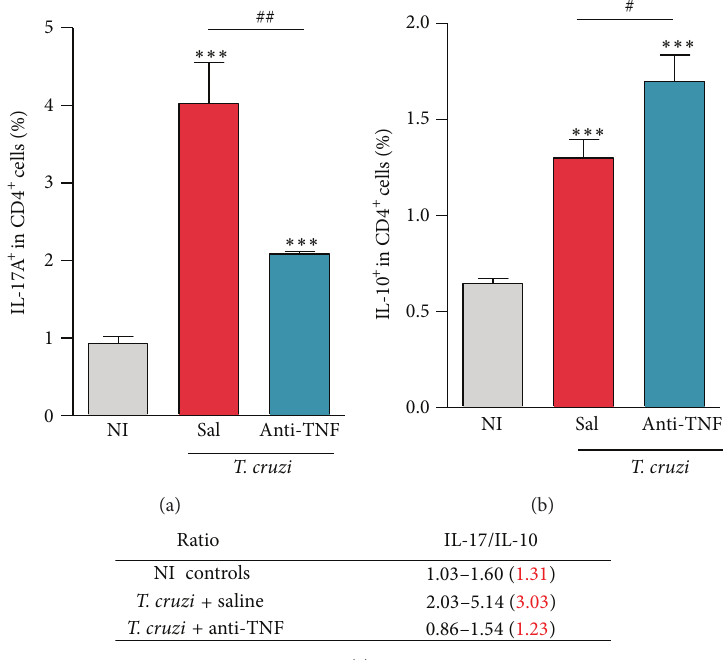
Figure 5: Anti-TNF therapy reduces the frequency of IL-17A + CD4 + cells but increases the frequency of IL-10 + CD4 + cells in chronically Trypanosoma cruzi -infected mice. C57BL/6 mice infected with 100 bt of the Colombian T. cruzi strain were treated from 120 to 150 dpi and analyzed at 150 dpi. (a) Frequencies of IL-17A + and (b) IL-10 + cells among CD4 + cells in the spleen [R1 (SSCxFSC)/R2 (TCR 𝛼𝛽 /CD4) gated]. (c) Relative ratios of IL-17A/IL-10 in saline-injected and anti-TNF treated infected mice. ∗∗∗ 𝑃 < 0.001 , T. cruzi -infected mice (saline injected or anti-TNF treated) compared to NI controls. # 𝑃 < 0.05 and ## 𝑃 < 0.01 , anti-TNF-treated compared to saline-injected T. cruzi -infected mice. Bar represents the mean ± SD of the studied group (4 to 6 mice). These data represent three independent experiments.